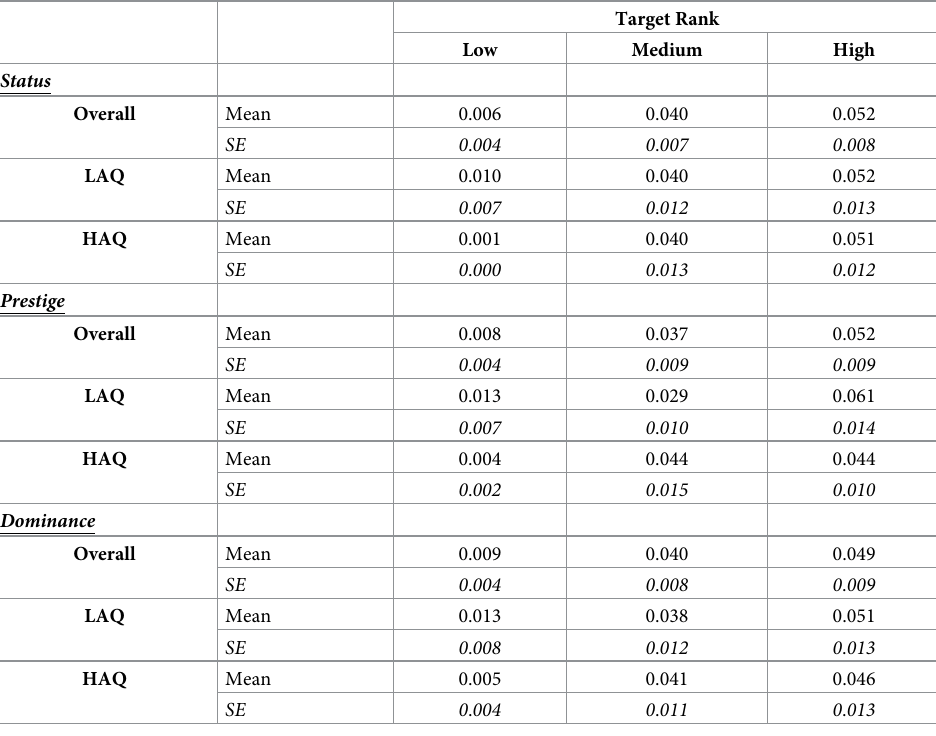
Table 2. Fixations to the eyes of low, medium, and high ranked